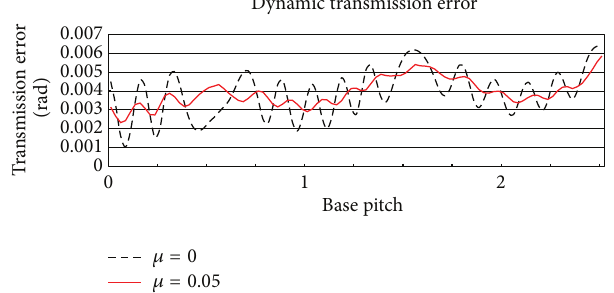
Figure 9: Dynamic transmission error results ( 𝜔 = 100rad/s).